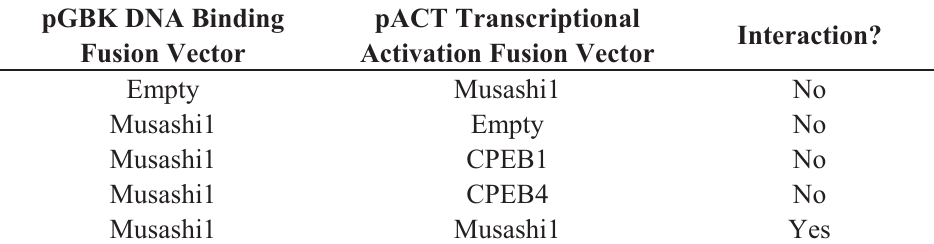
Table 2. Musashi1 interaction with CPEB1 and CPEB4 is